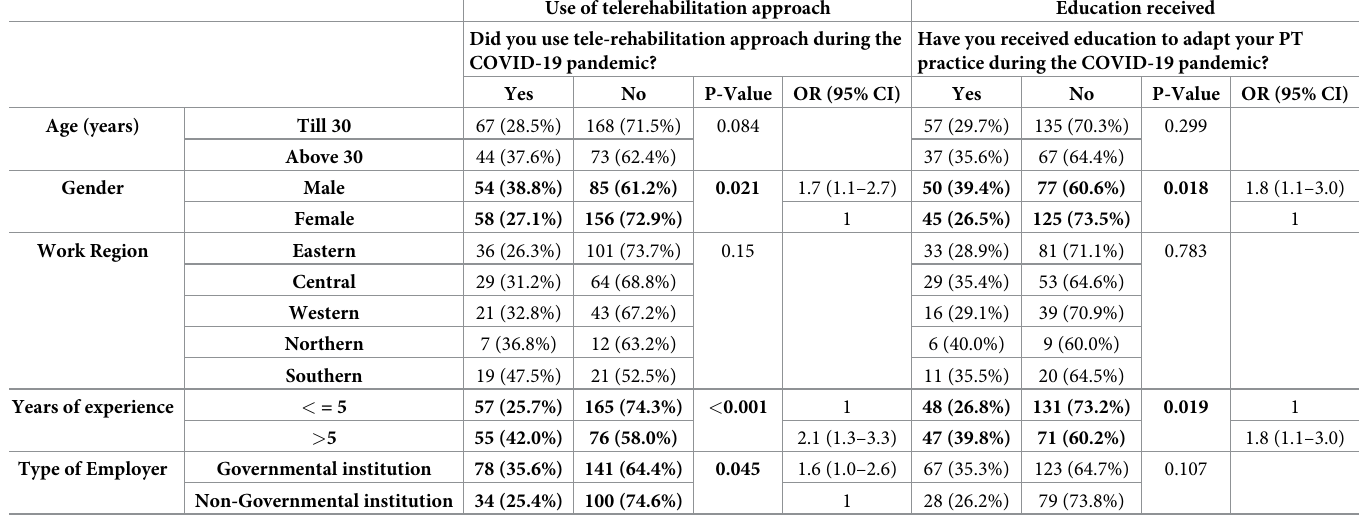
Table 2. Response to the COVID-19